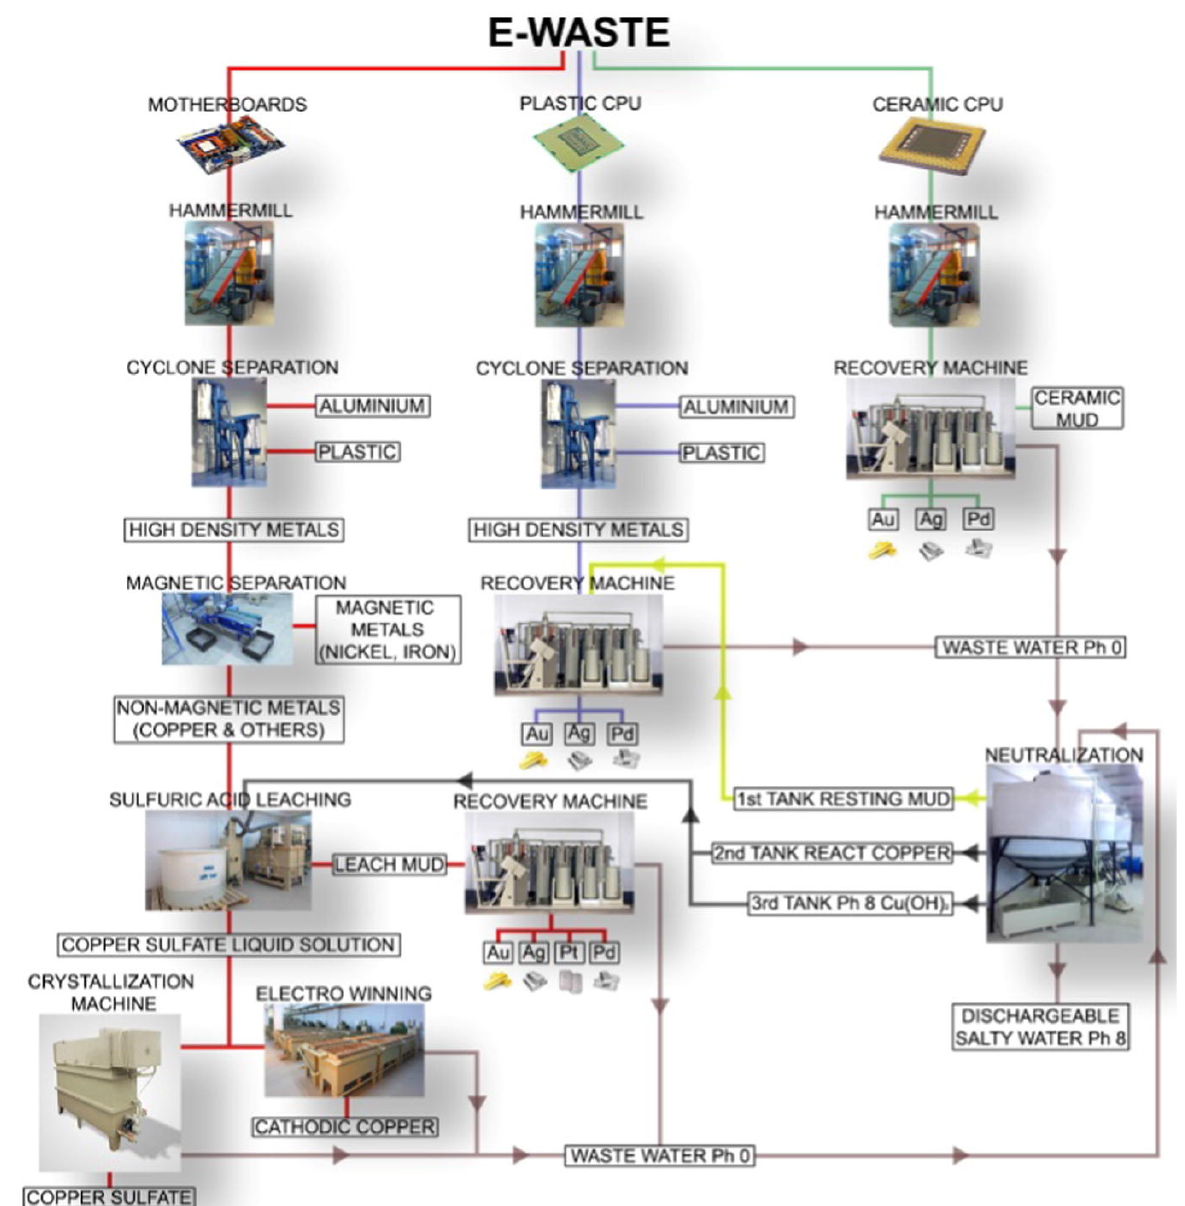
Figure 4. A simple flowchart of the motherboard, CPU, and ceramic CPU recycling plant [20].